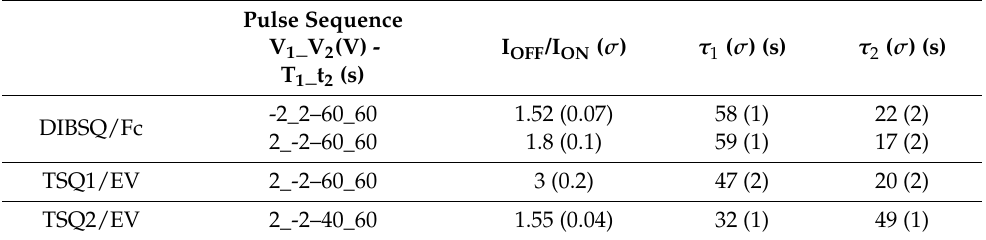
Table 3. Electrofluorochromic switching performances of DIBSQ and TSQs based devices a . Pulse